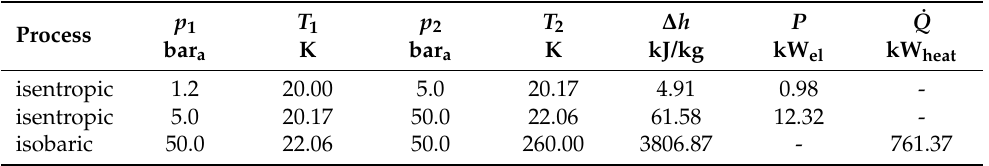
Table 3. Arrangement: liquid low-pressure pump, liquid high-pressure pump, heat exchanger/ vaporizer; isentropic and isobaric change of state for the consideration of the required power, divided into electrical power and heat